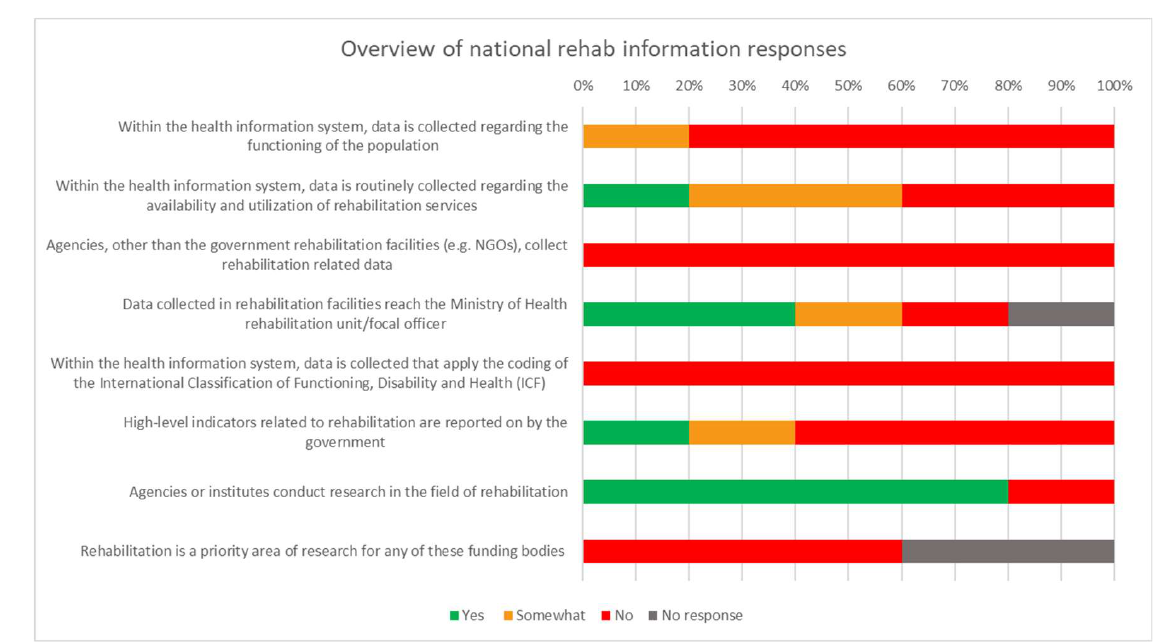
Figure 2 . Overview of responses related to national rehabilitation information . Figure 2. Overview of responses related to national rehabilitation